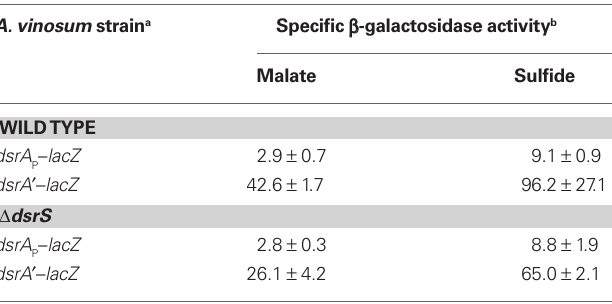
Table 7 | Expression of transcriptional and translational gene